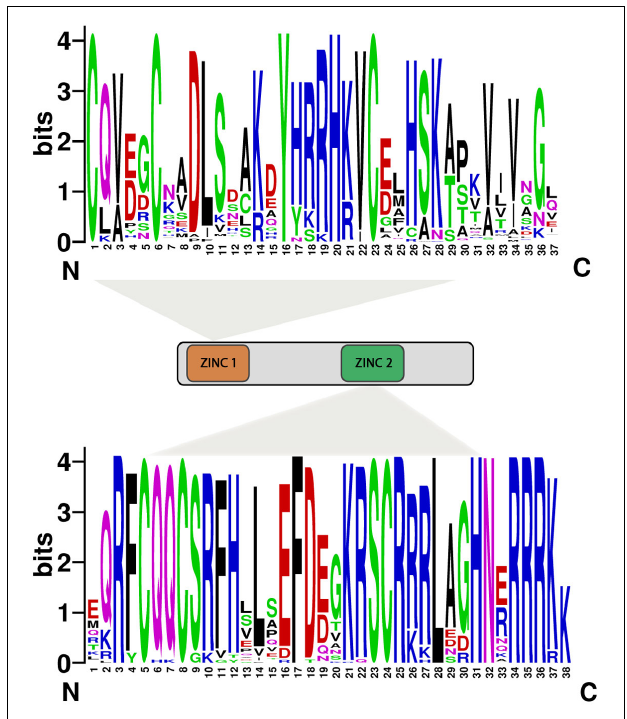
FIGURE 4 | Domain compositions of SBP-box genes. Eighty SBP-box genes have both the characteristics of ZINC1 (Cys-Cys-His-Cys) and ZINC2 (Cys-Cys-Cys-His). The bit score represents the information content for each position in the sequence.